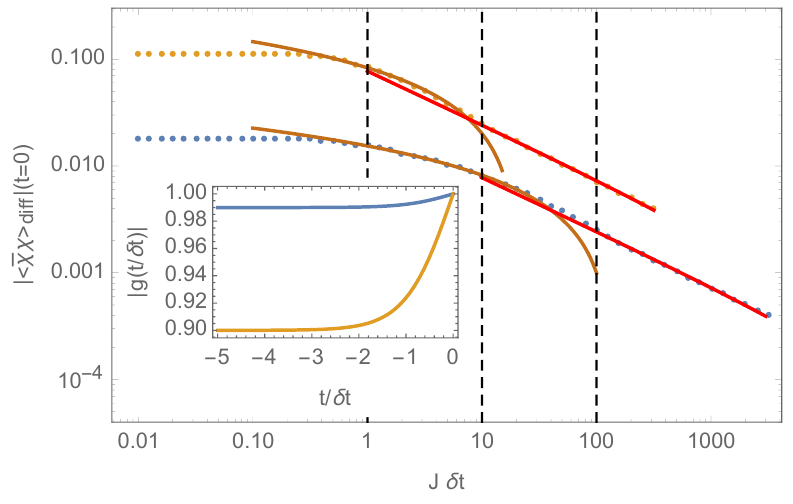
Figure 2 . The response h (cid:22) (cid:31)(cid:31) i di(cid:11) at (cid:12)xed t = 0 as a function of J(cid:14)t for the (one-dimensional) transverse (cid:12)eld Ising model. The time-dependences of the coupling g ( t ) are given in the inset. The brown curves are the log (cid:12)ts in the fast regime, P log J(cid:14)t + Q , and the red lines are the (cid:12)ts to the Kibble-Zurek scaling in the slow regime, P 0 ( J(cid:14)t ) (cid:0) 1 = 2 + Q 0 . The dotted lines indicate expected cross- overs at J(cid:14)t (cid:24) 1 and J(cid:14)t (cid:24) 1 =(cid:15) in . The blue dots are the response for an initial gap of (cid:15) in = 0 : 01 and the best (cid:12)ts give P = (cid:0) 0 : 00313, Q = 0 : 0154, P 0 = 0 : 0248 and Q 0 = 5 : 90 (cid:2) 10 (cid:0) 5 . For the yellow dots, (cid:15) in = 0 : 1 and the best (cid:12)ts give P = (cid:0) 0 : 0273, Q = 0 : 0830, P 0 = 0 : 0777 and Q 0 = 5 : 10 (cid:2) 10 (cid:0) 4